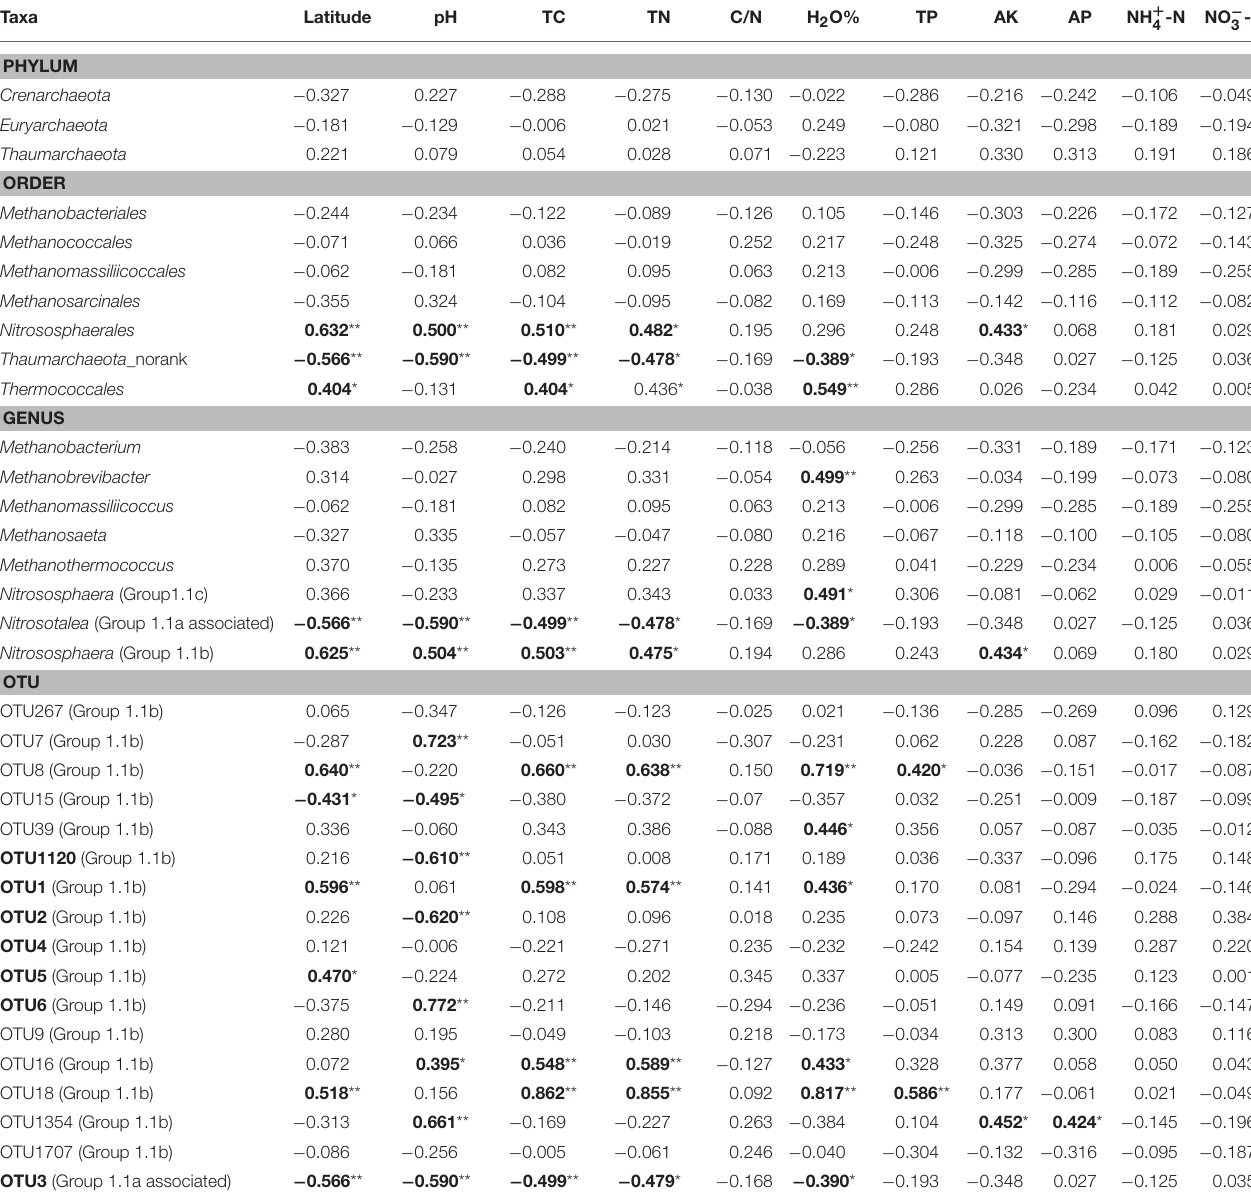
TABLE 1 | The relationships between soil physicochemical properties and the relative abundance of archaea at phylum, order, genus, and OTUs level in black soils using Pearson’s correlation.